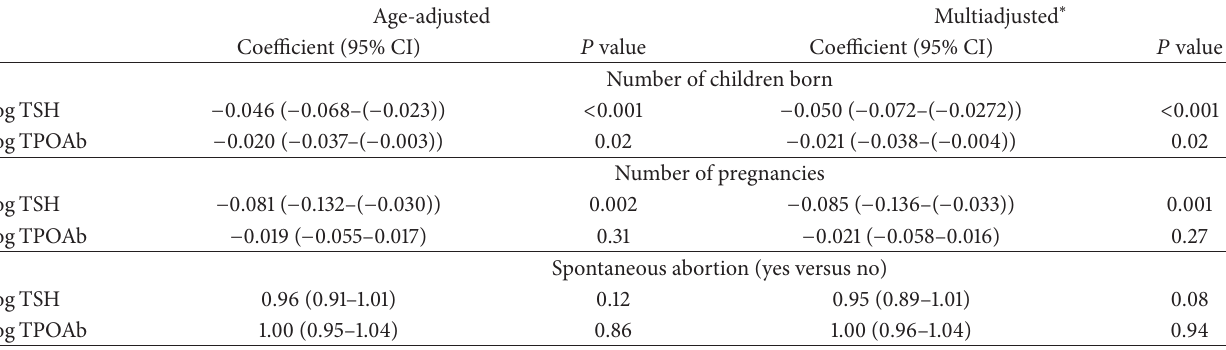
Table 2: Association between TSH (mU/L) and TPOAb (U/mL) levels and the number of children born, the number of pregnancies, and spontaneous abortion.